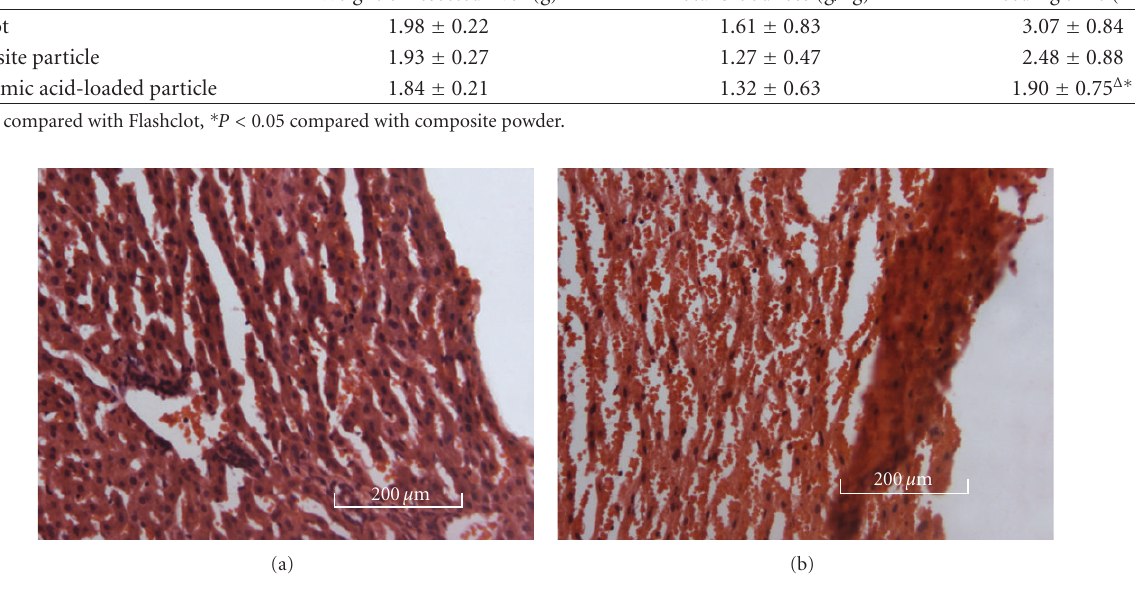
Figure 9: HE- stained histological image ( × 200), (a) microparticles group; (b) Flashclot